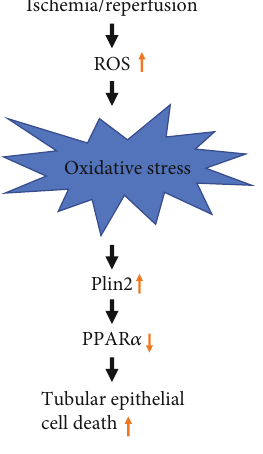
Figure 5: Proposed schema of the pathway for I/R-induced AKI, involving the promotion of mitochondrial reactive oxygen species (ROS) generation, upregulation of Plin2, and downregulation of PPAR α , resulting in cell